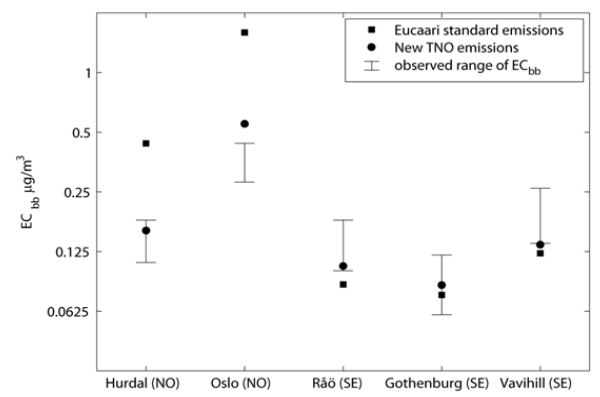
Fig. 13. Levoglucosan concentration and modelled EC from biomass burning (EC bb = EC from open burning of biomass + EC from residential wood combustion) at Hyytiälä in April 2007. The levoglucosan concentrations (vertical lines) are scaled by factors of 0.3 to 5.6 to be comparable to EC bb (see text). Model EC bb are from two different model setups, one using the EUCAARI emissions for RWC (squares) and one using the new TNO inventory for RWC (dots). The model calculated EC from the open burning of biomass is also shown (EC vegfire , red line; values < 0.001 µg m -3 are not shown). Unit: µg m -3 .